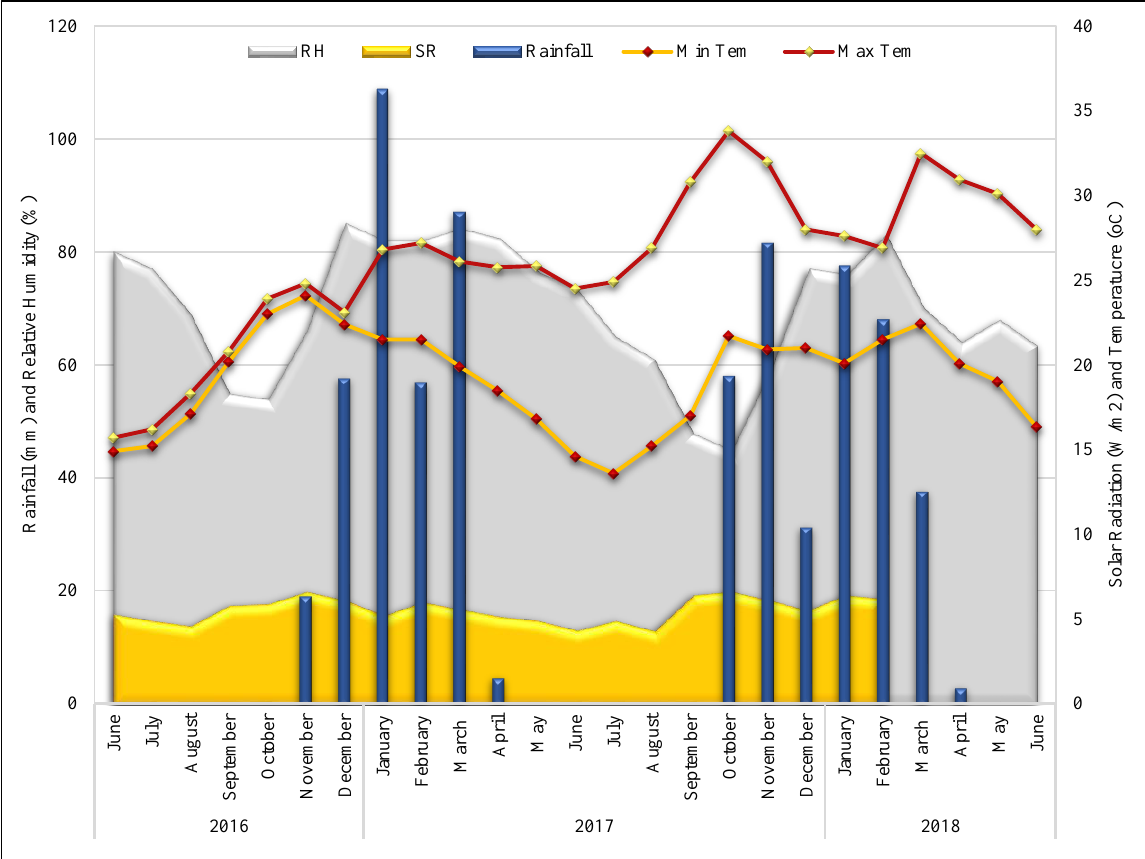
Figure 2. Weather from June 2016 to June 2018 for the study area